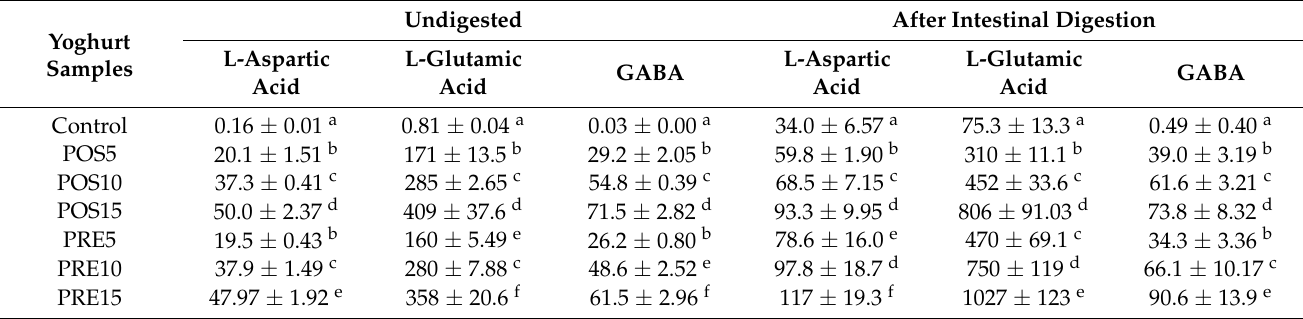
Table 2. Concentrations (mg/100 g yoghurt) of key free amino acids in control and tamarillo fortified yoghurts before undigested and after intestinal in vitro